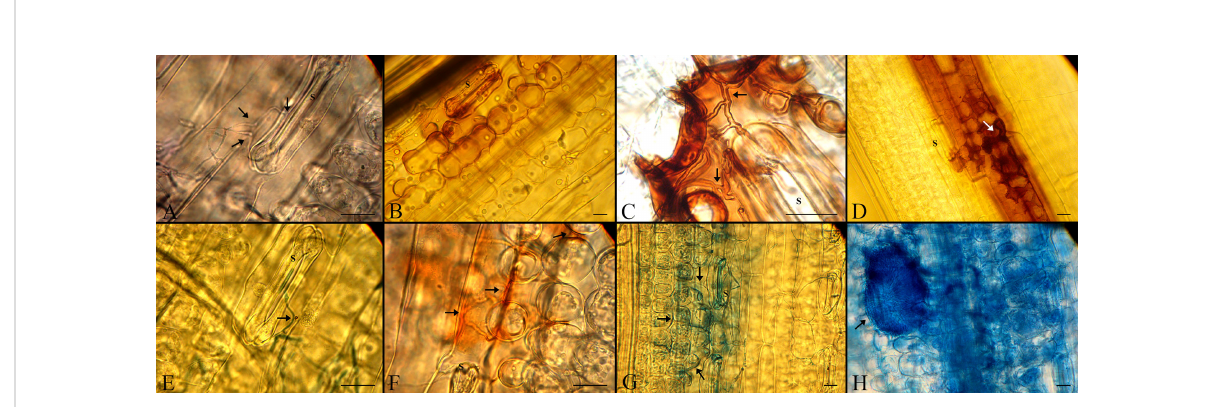
FIGURE 6 Histopathological events in the cv. Sha fi r infected by either the WT IPO323 (incompatible interaction) or the D AvrStb6#33 (compatible interaction) strains. (A, E) Both fungal strains germinated by 2 dpi and penetrated directly through stomata (S stands for the stomata and arrows represent the germinated spores). (B, F) Accumulation of H 2 O 2 as seen by the formation of red-brown staining in the incompatible (upper panel) and compatible interactions (lower panel), respectively at 4 dpi. (C, G) Extensive accumulation of H 2 O 2 in the cv. Sha fi r infected by IPO323, blocks further hyphal growth while hyphal growth of D AvrStb6#33 was found in the cv. Sha fi r at 8 dpi. (D) Cytoplasmic-like shrinkage occurred in the incompatible context at 8 dpi. (H) A-sexual fl ask-shaped fruiting buddings were formed in the compatible interaction at 12 dpi. The scale bars are 20 m